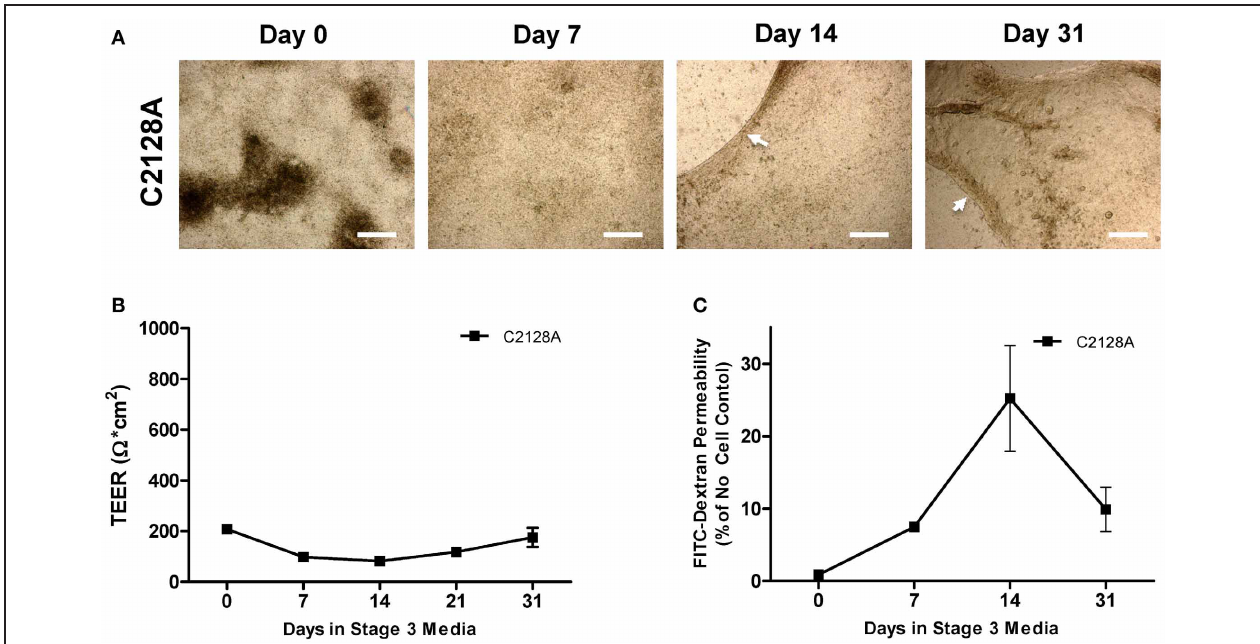
late Stage 3 differentiation (arrow heads), resulting in large holes on transwell inserts. Scale bar, 250 μ m. (B) C2128A cells do not show increasing TEER with increasing days in Stage 3 culture. (C) C2128A shows high FD150 permeability at later stages of differentiation. N = 3; Error bars represent